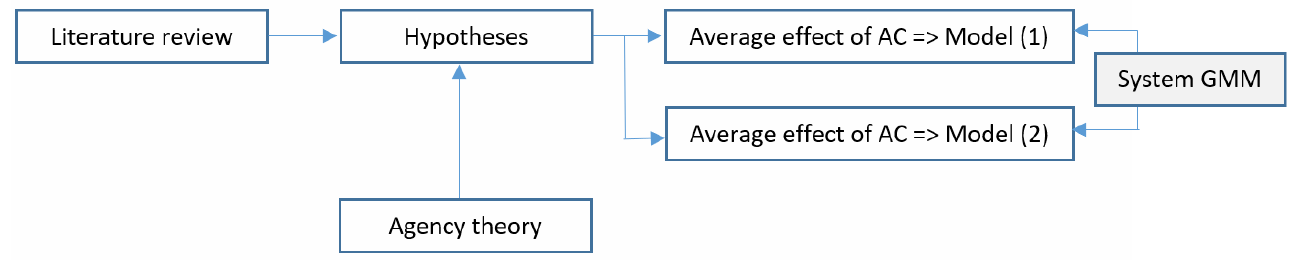
Figure A1. Research design. Table A1. Variable definition.